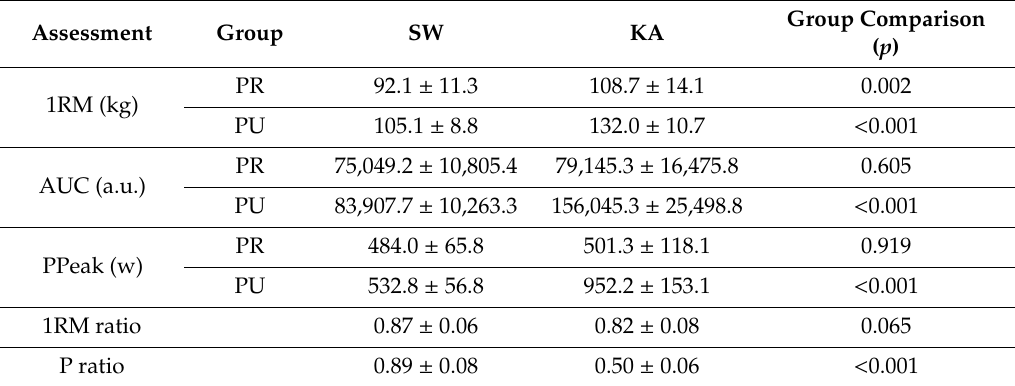
Table 1. Performance at maximum strength and power assessments in SW and KA. 1RM = 1 repetition maximum; AUC = area under the load-power curve; P ratio = power ratio. KA = kayak group; SW = swimming group.